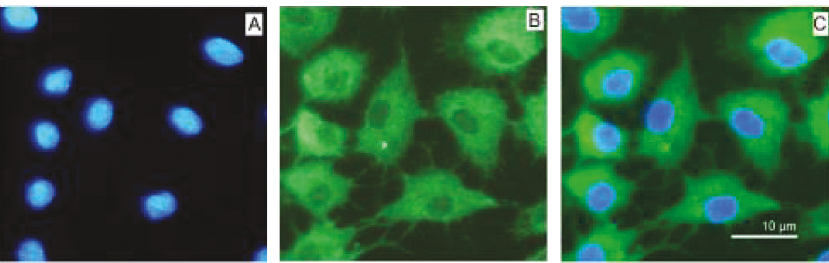
Figure 1: Primary culture and identification of